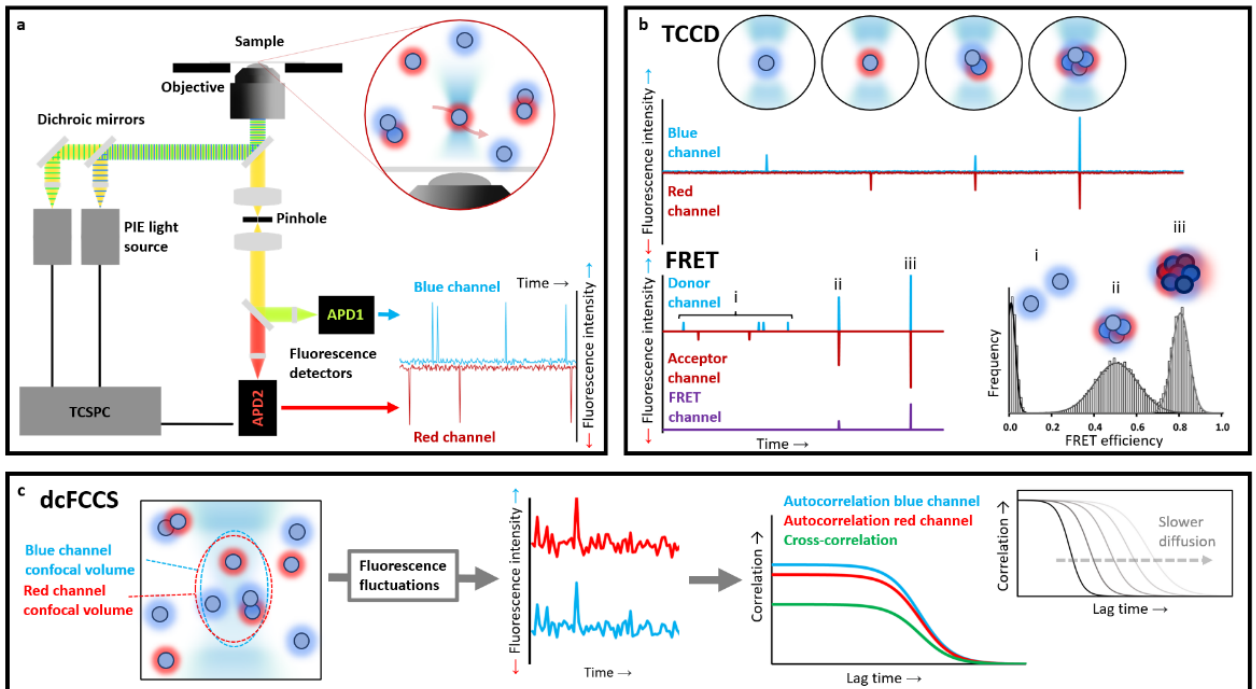
Figure 2. Typical diffusion-based fluorescence confocal microscopy setup and techniques. ( a ) Scheme of a dual-colour fluorescence confocal microscope for the detection of fluorescently labelled particles passing through the calibrated confocal volume (red circle, upper right) with pulsed interleaved excitation (PIE). Time traces are recorded simultaneously in both channels. During most of the time, the illuminating volume is empty until a moment in which a fluorescently labelled particle crosses the volume and its fluorescence emission is detected as a burst in each or both detection channels. ( b ) Visual representation of the two-colour coincidence detection (TCCD) and Förster’s resonance energy transfer (smFRET) analysis from single-molecule fluorescence time traces (in blue the donor emission after direct excitation, in red the acceptor emission after direct excitation and in purple the acceptor emission after indirect FRET excitation). Isolated fluorescence events detected as single bursts are analysed and different subpopulations of labelled molecules (i, ii and iii) can be identified and quantified. ( c ) A schematic for the dual-colour fluorescence cross-correlation spectroscopy (dsFCCS) method. The continuous entry/exit of labelled molecules cause fluorescence fluctuations in the calibrated confocal volume, which can be time-correlated, giving rise to auto- and cross-correlation curves from which concentrations and diffusion coefficients for single- and dual-labelled particles can be extracted.